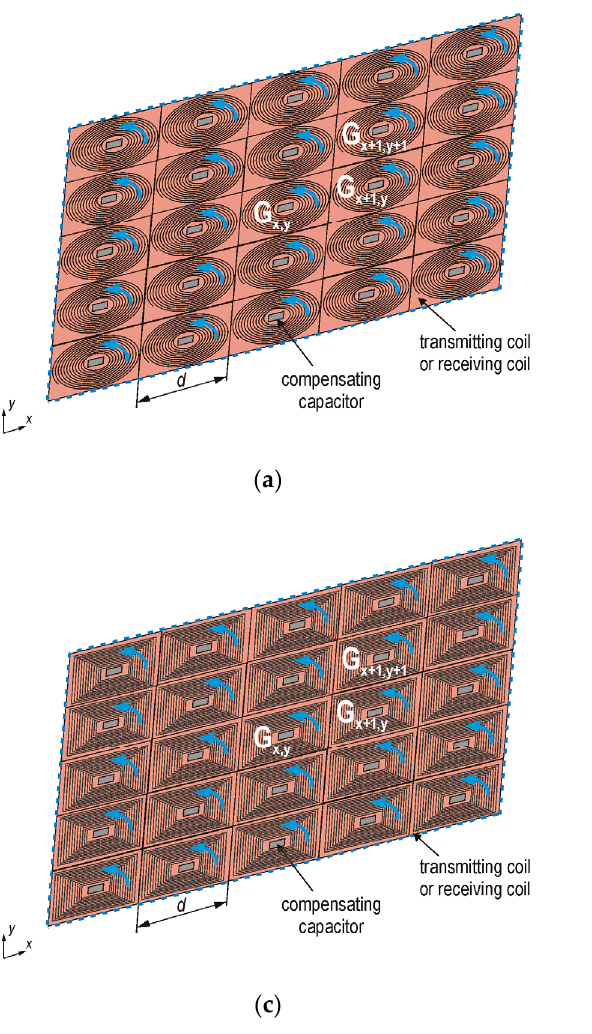
Figure 3. The studied transmitting/receiving surface composed of: ( a ) circular coils with the same winding direction, ( b ) circular coils with the opposite winding direction, ( c ) square coils with the same winding direction, ( d ) square coils with the opposite winding direction.